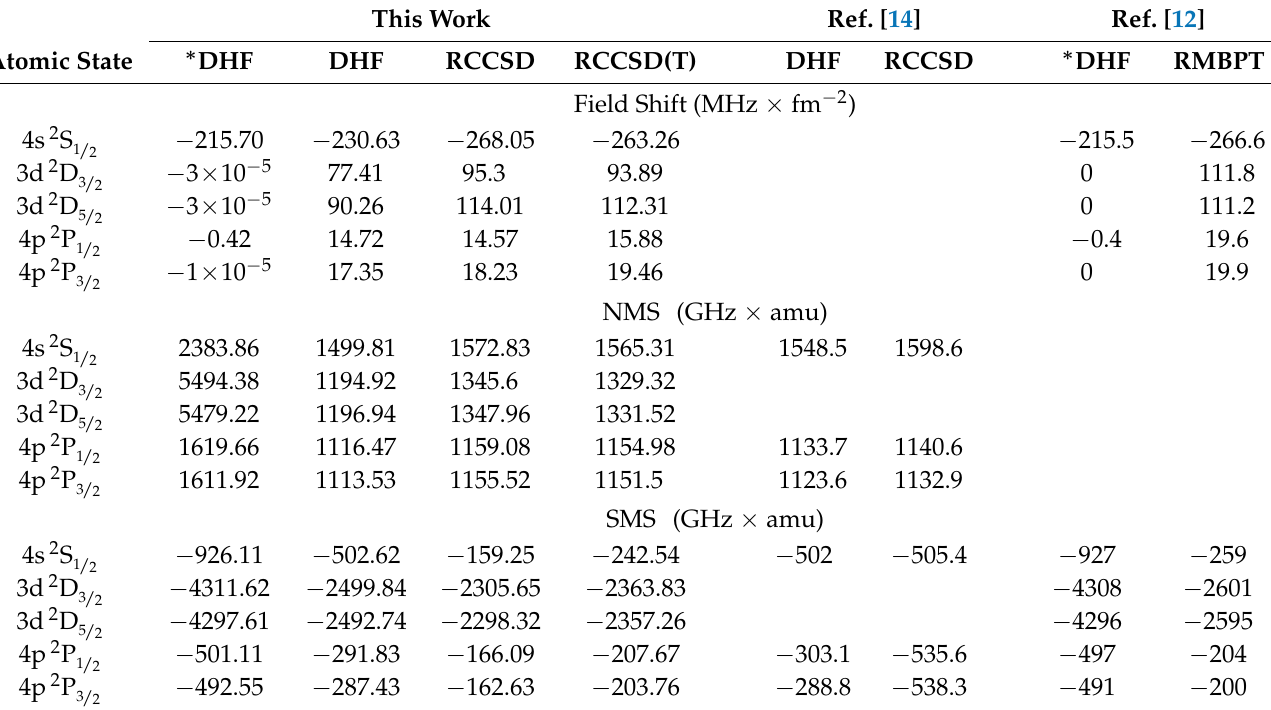
Table 2. Isotope shift pre-factors comparison for Ca II as obtained with different numerical calculation methods, compared to previous theoretical work in [12,14]. Abbreviations are explained in the